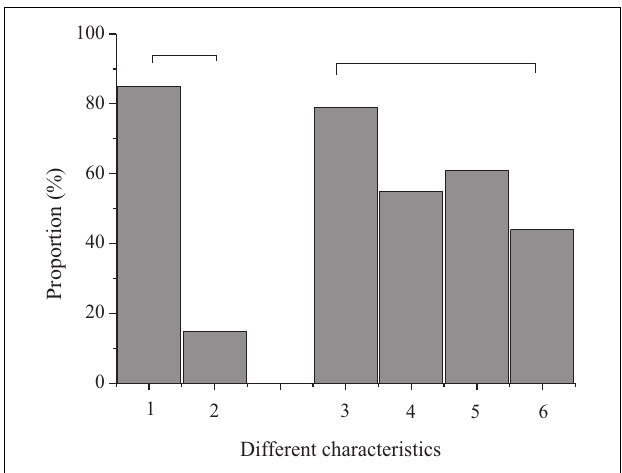
FIGURE 9 | Learning effect of intelligent piano for preschool children (“ ” represents the same dimensions; 1, children play new music actively; 2, children do not play new music actively; 3, intelligent piano has partner training function; 4, the intelligent piano can be used to teach remotely; 5, the intelligent piano has smart scores; 6, the intelligent piano has entertainment function).